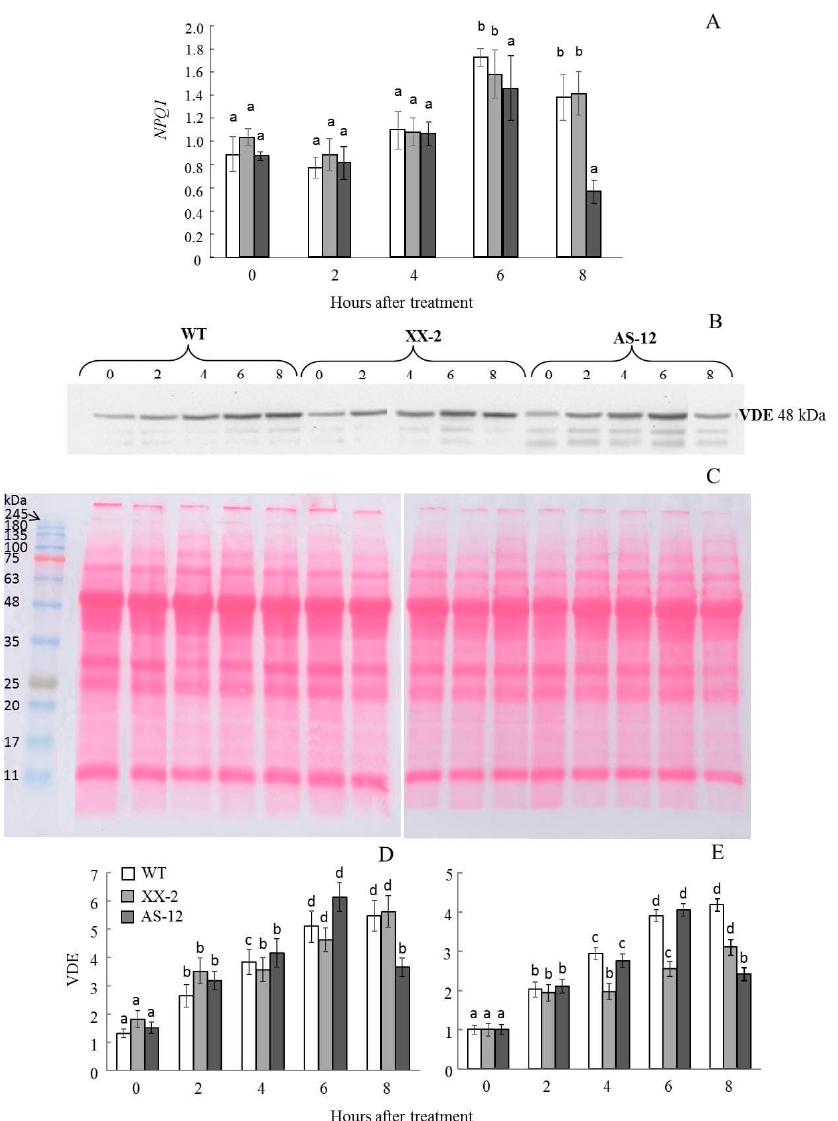
Figure 6. Expression of NPQ1 , which encodes violaxanthin de-epoxidase (VDE) ( A ), western blot analysis of VDE ( B ), reversible Ponceau S staining control ( C ), and the absolute ( D ) and relative changes (for each line in comparison to those at 0 h) ( E ) in VDE protein levels in leaves of WT, XX-2 and AS-12 Arabidopsis thaliana plants grown at 90 μ mol m − 2 s − 1 (0 h) and after 2–8 h of moderately high light (400 μ mol m − 2 s − 1 ). For NPQ1 expression values, the final number of expression values (ten) was used as n for statistical calculations. The transcript amounts are presented in relation to AT2G28390 and AT4G34270 housekeeping gene [23] expression values. Significant differences between mean values within each gene analysis are indicated by different letters (ANOVA, Duncan’s test, p < 0.05). For VDE amount ( C ), data are presented as mean ± SE of values from three replicates. Significant differences between mean values (Kruskal-Wallis test, p < 0.05) are indicated by different letters (a, b, c, d). The same letters indicate no significant differences between the means.